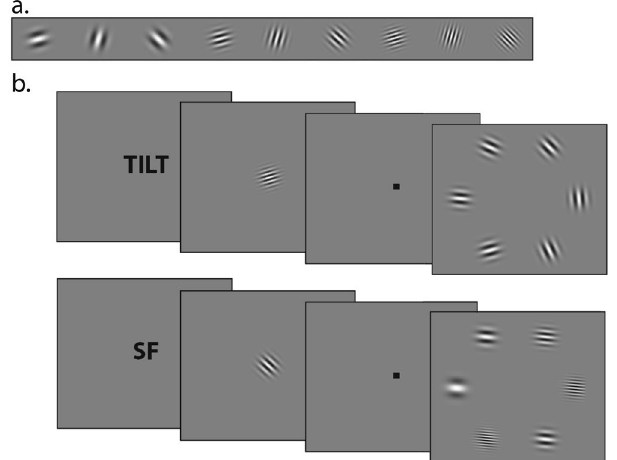
Figure 1. ( a ) The 9 Gabor images used as cues in the experiment. ( b ) The experimental procedure for the two search